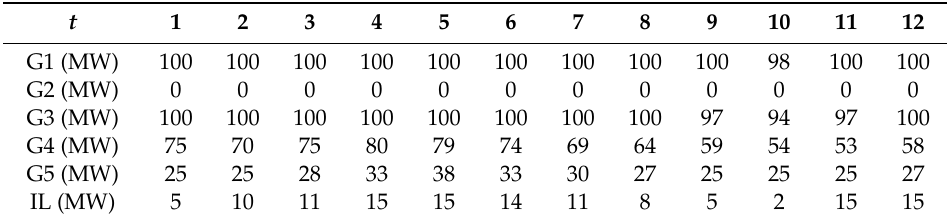
Figure 3. Forecasted and actual net load in a typical scenario. Table 4. Power outputs of generating units and IL on the condition of accurate predictions with no